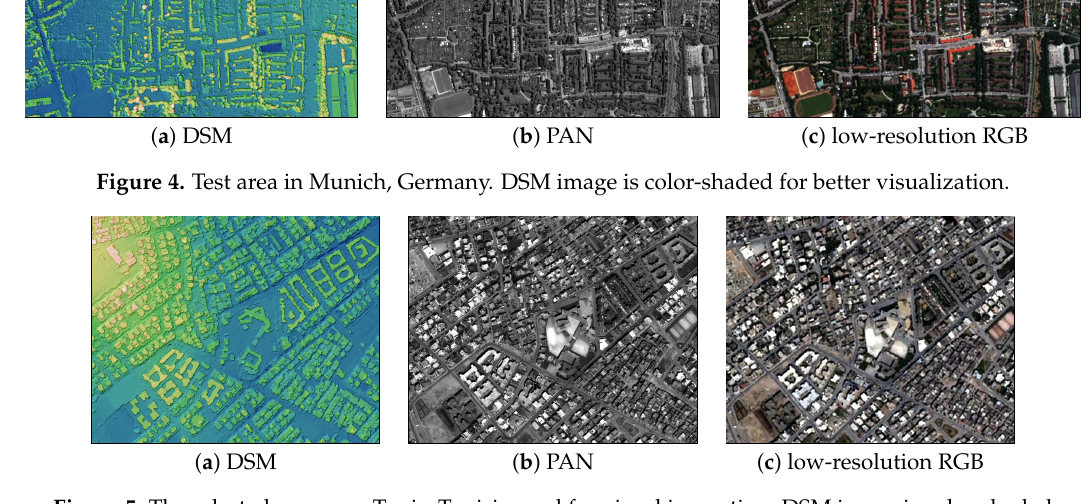
Figure 5. The selected area over Tunis, Tunisia used for visual inspection. DSM image is color-shaded for better visualization.